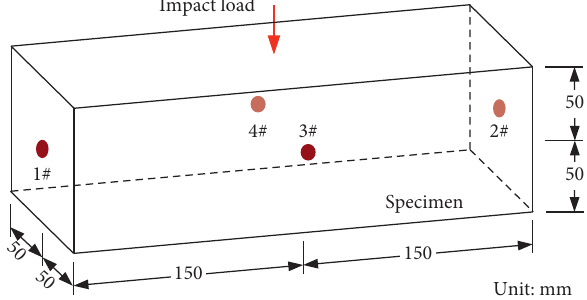
Figure 5: Location of piezoceramic